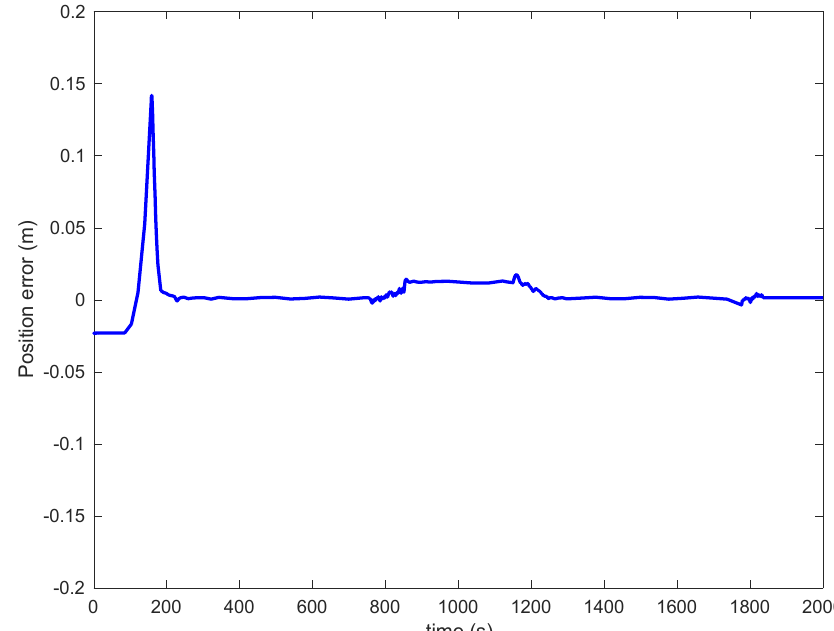
Figure 5. Position error.